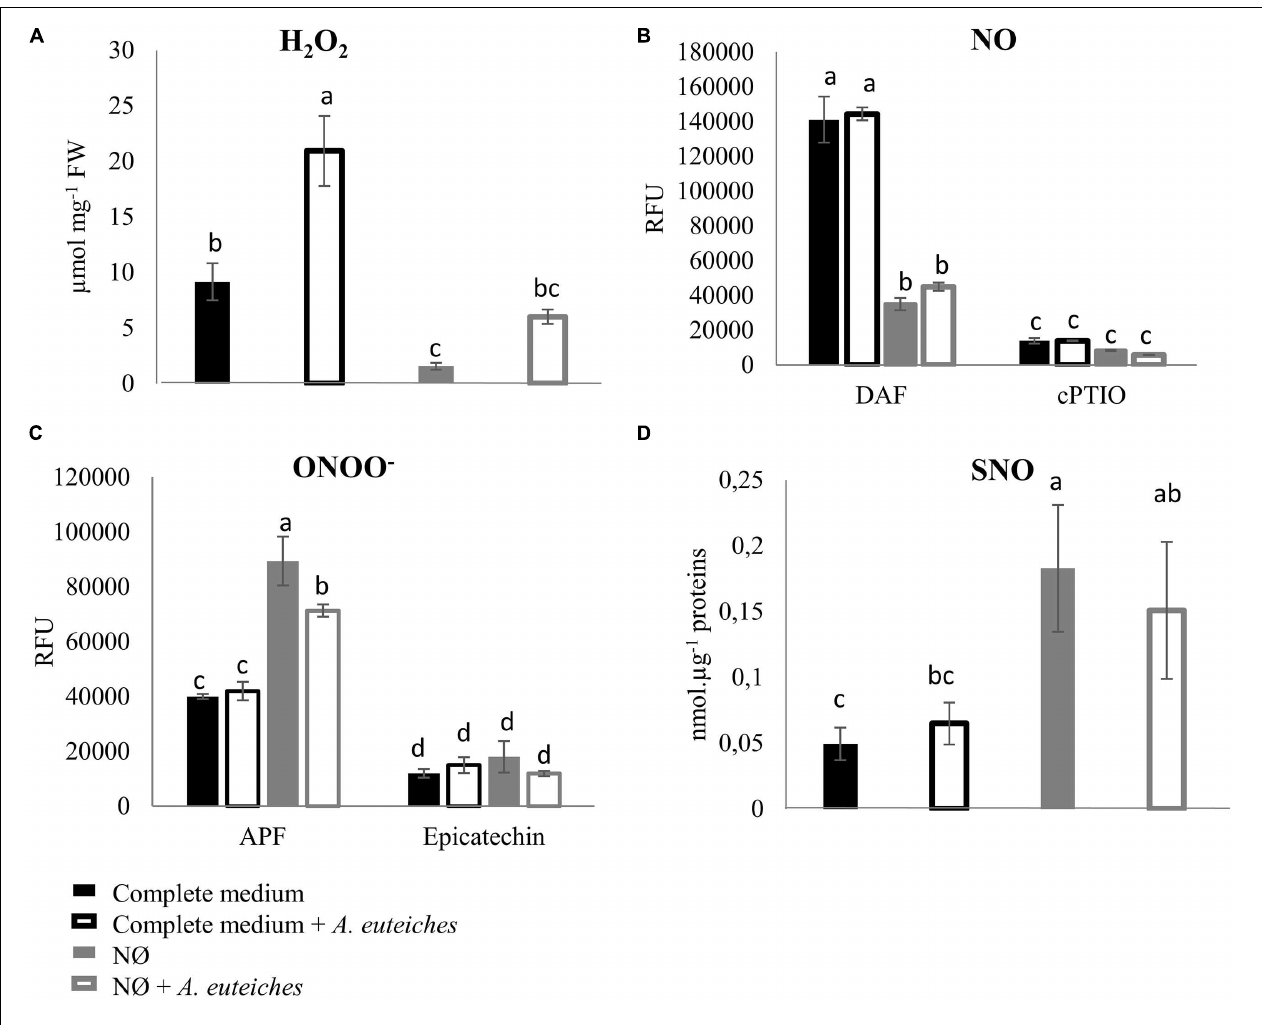
FIGURE 4 | H 2 O 2 , NO, ONOO − , and SNO quantification in Medicago truncatula roots 7 dpi. M. truncatula was cultivated on complete medium or NØ medium, and roots were harvested 7 days after inoculation with A. euteiches and used to detect H 2 O 2 , NO, and ONOO − concentrations using fluorescent probes, and SNO concentrations using the Saville–Griess assay. (A) H 2 O 2 quantification using 10 µ M Amplex Red R (cid:13) fluorophore and 0.2 U/mL of peroxidase. Catalase (1 U/ µ L), used as an H 2 O 2 scavenger, abolished Amplex Red R (cid:13) fluorescence. (B) NO quantification using the fluorophore DAF (10 µ M). Root extracts were pre-incubated or not with 500 µ M cPTIO as an NO scavenger. (C) ONOO − quantification using the fluorophore APF (5 µ M). Root extracts were pre-incubated or not with 1 mM of the ONOO − scavenger epicatechin. (D) SNO quantification by the Saville–Griess assay. Error bars indicate standard errors ( n = 4 for A–C ; n = 14 for D ), and letters indicate significant differences ( p < 0.05). Data from one representative experiment out of three independent experiments for H 2 O 2 , NO, and ONOO − concentrations, and data corresponding to two independent experiments pooled together for SNO concentrations. RFU, relative fluorescence units.